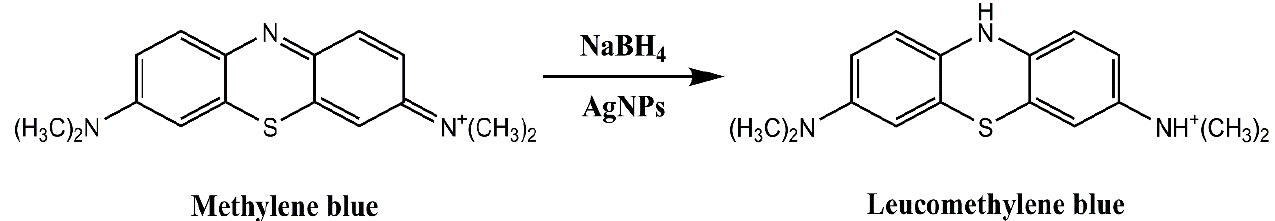
Figure 7. Schematic representation of reduction of Methylene Blue (MB).